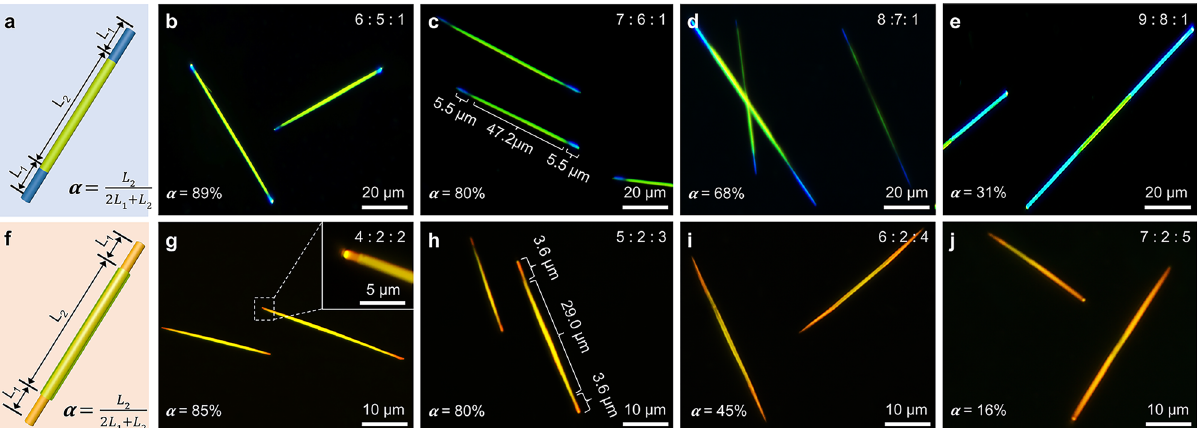
Fig. 5 Elaborate control for the length ratio of the two segments of triblock heterostructure nanowires. a illustration for the length ratio between the blue part and the olive part of the triblock nanowire. b – e FM images of the blue-olive-blue triblock nanowires with different length ratio, the molar ratio of BGP, OFN and TFPA was set to 6:5:1 ( b ), 7:6:1 ( c ), 8:7:1 ( d ), 9:8:1 ( e ). f Schematic illustration of the length ratio of the orange segment to the olive segment of the triblock nanowire. g – j FM images of the orange-orange/olive-orange triblock nanowires with different length ratio, the molar ratio of BGP, OFN and TFPA was set to 4:2:2 ( g ), 5:2:3 ( h ), 6:2:4 ( i ), 7:2:5 ( j ).